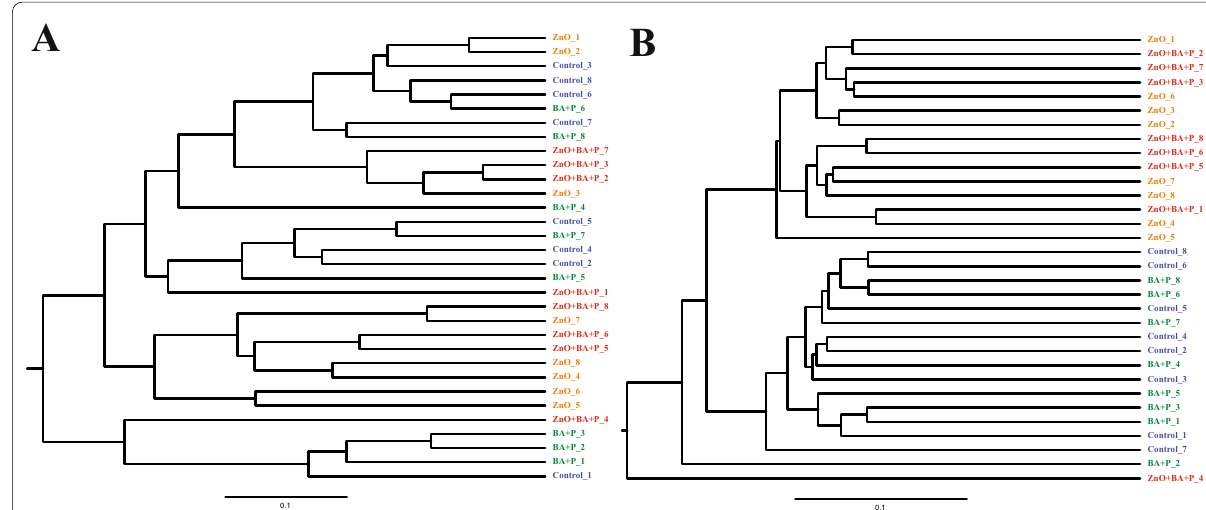
Fig. 4 Dendrograms. Dendrograms comparing the similarities between bacterial community structure ( A ) and membership ( B ) present in the cecum of post-weaning piglets supplemented with Zinc Oxide (ZnO), Benzoic acid plus probiotic (BA supplementation (Control)